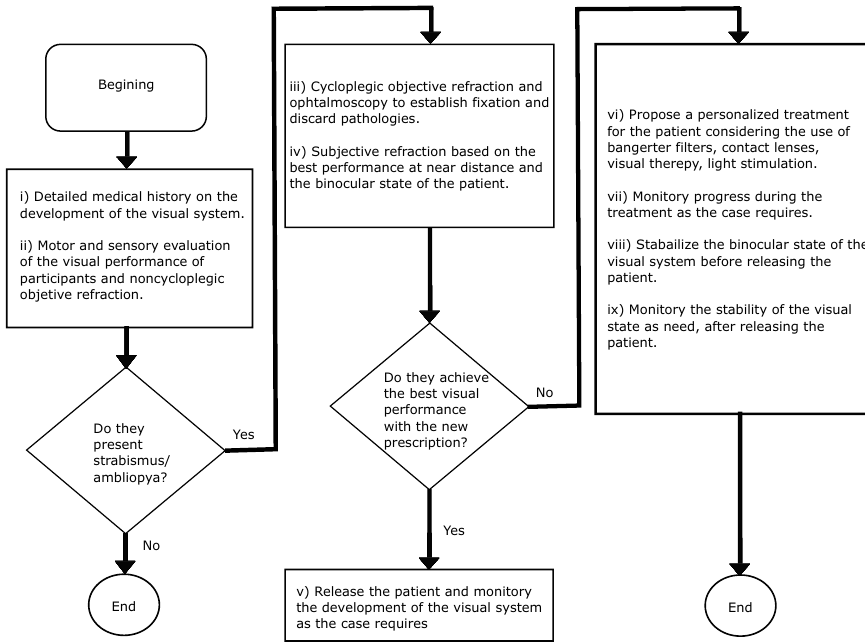
Figure 1. Flowchart in assessing patients, and possible treatments for individuals diagnosed with strabismus and